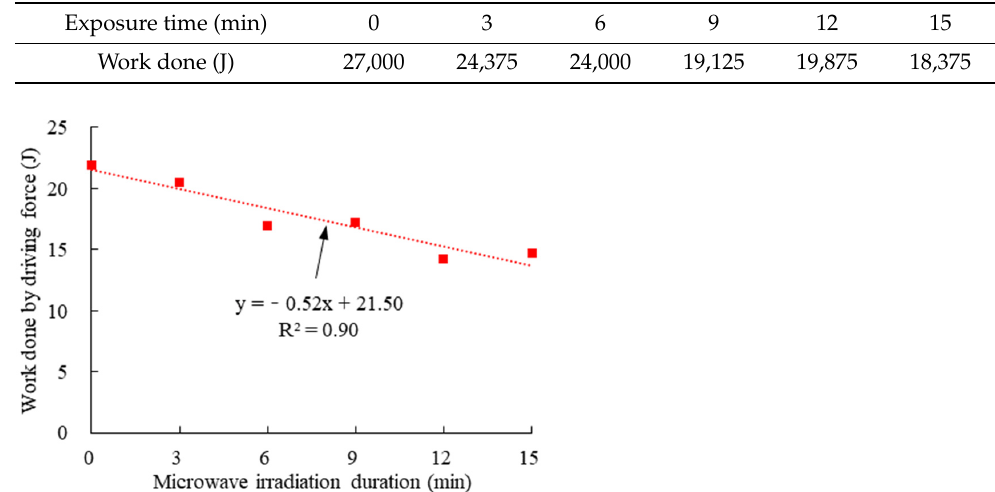
Table 6. The work done by the rolling force at different microwave exposure times.